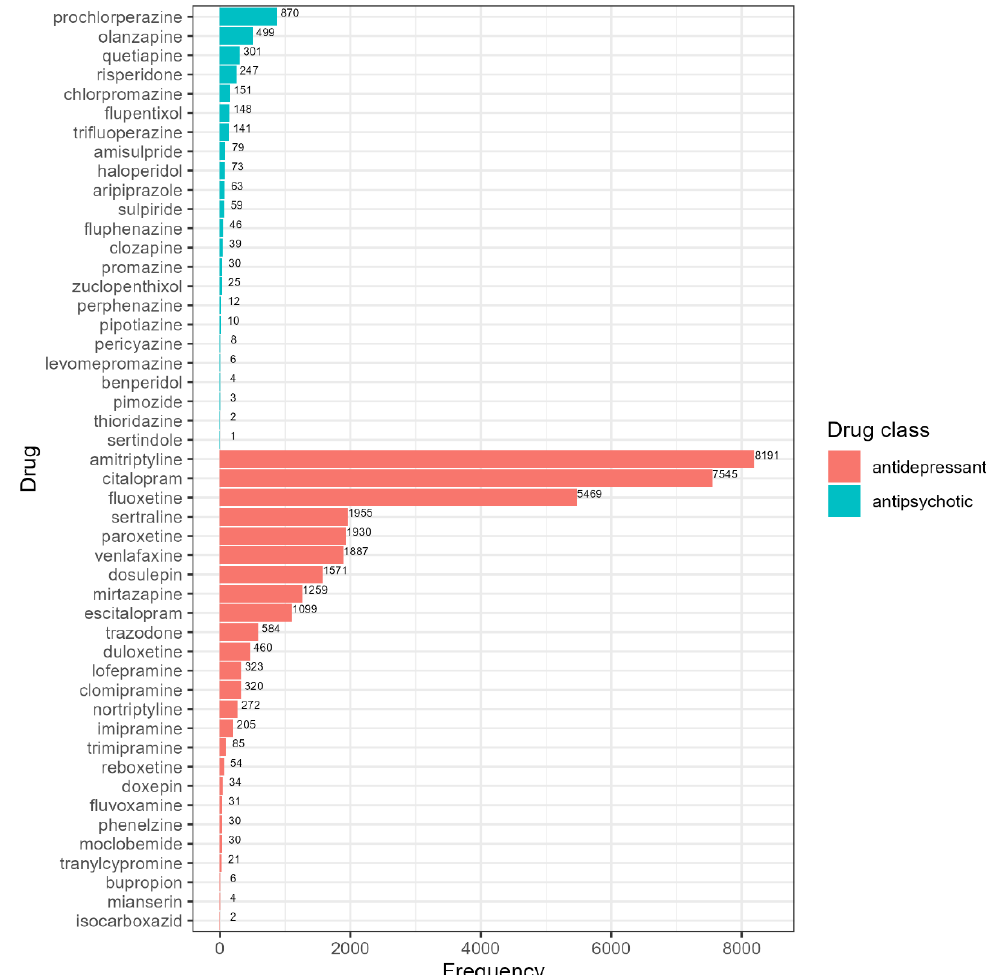
Figure 1. Frequency table of identified antipsychotics (blue bars) and antidepressants (red bars) in UK Biobank. Table 1. Demographic Data for Study Sample. Table 2. Association between CYP2D6 metabolic phenotype and HbA1c levels among